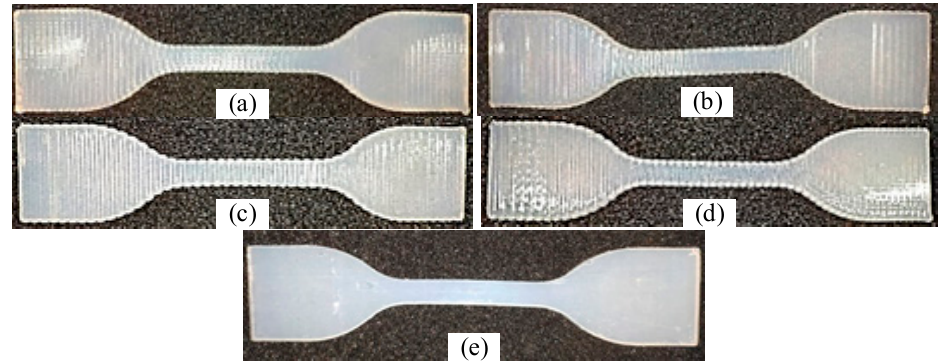
Figure 5. Detail of the AM specimens: ( a ) X = 0.8 mm, F =2520 mm/min, P = 25 Psi; ( b ) X = 1.0 mm, F = 2100 mm/min, P = 25 Psi; ( c ) X = 1.2 mm, F = 1620 mm/min, P = 25 Psi; ( d ) SMO: X 1 = 1.2 mm, X 2 = 1.0 mm, X 3 = 0.8 mm, F 1 = 1620 mm/min, F 2 = 2100 mm/min, F 3 = 2520 mm/min, P = 25 Psi; ( e ) injection molded specimen. The spots are caused by dust.